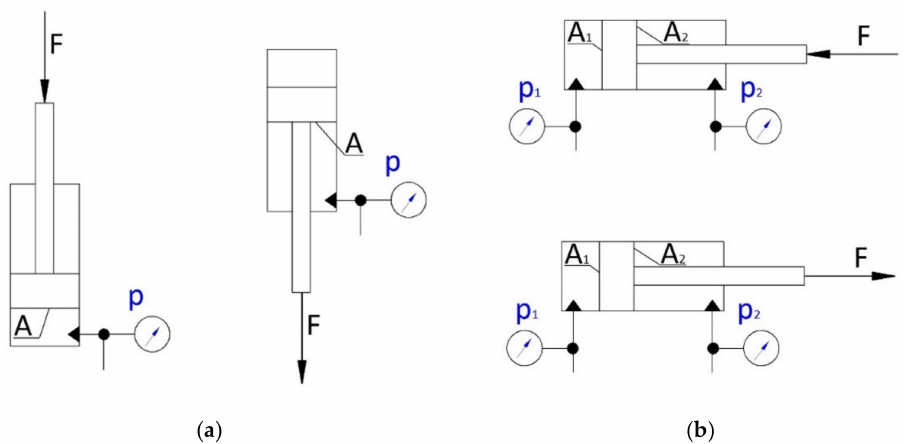
Figure 3. Mathematical models of actuator loads: ( a ) single-acting actuator; ( b ) double-acting actuator.